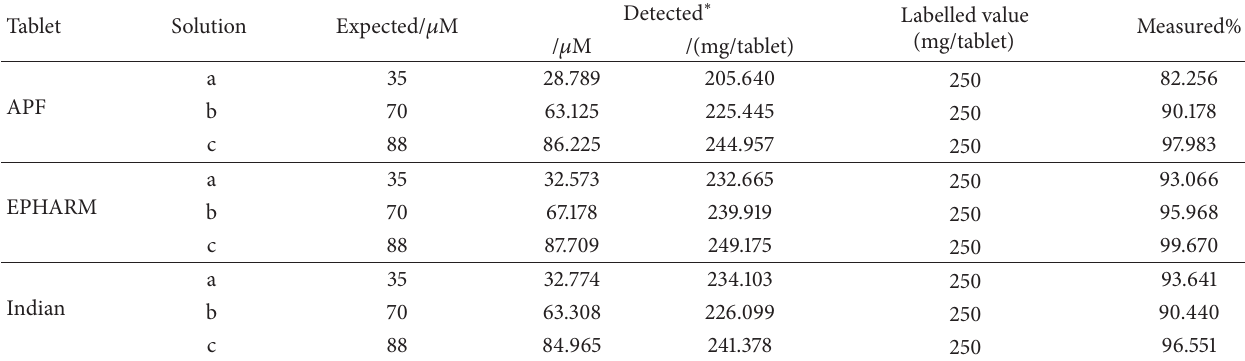
Table 1: Amount of MTZ detected in three brands of drug samples using the developed method.